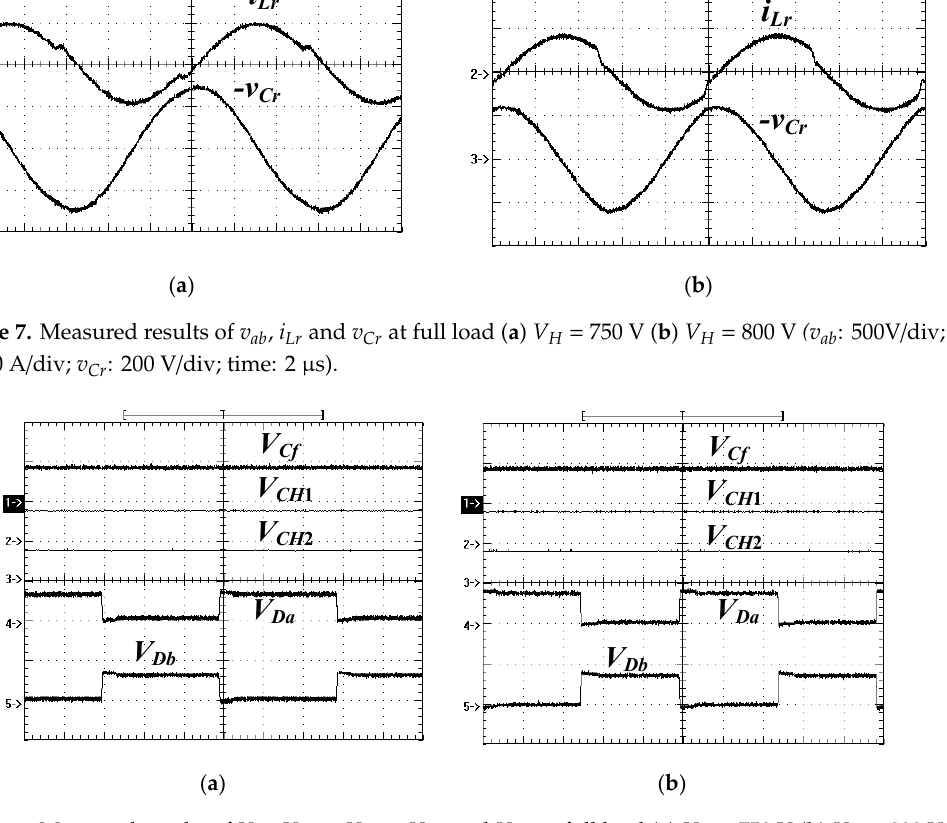
Figure 8. Measured results of V Cf , V CH 1 , V CH 2 , V Da and V Db at full load ( a ) V H = 750 V ( b ) V H = 800 V (v Cf , V CH 1 , V CH 2 , V Da , V Db : 500 V/div; time: 2 μ s).